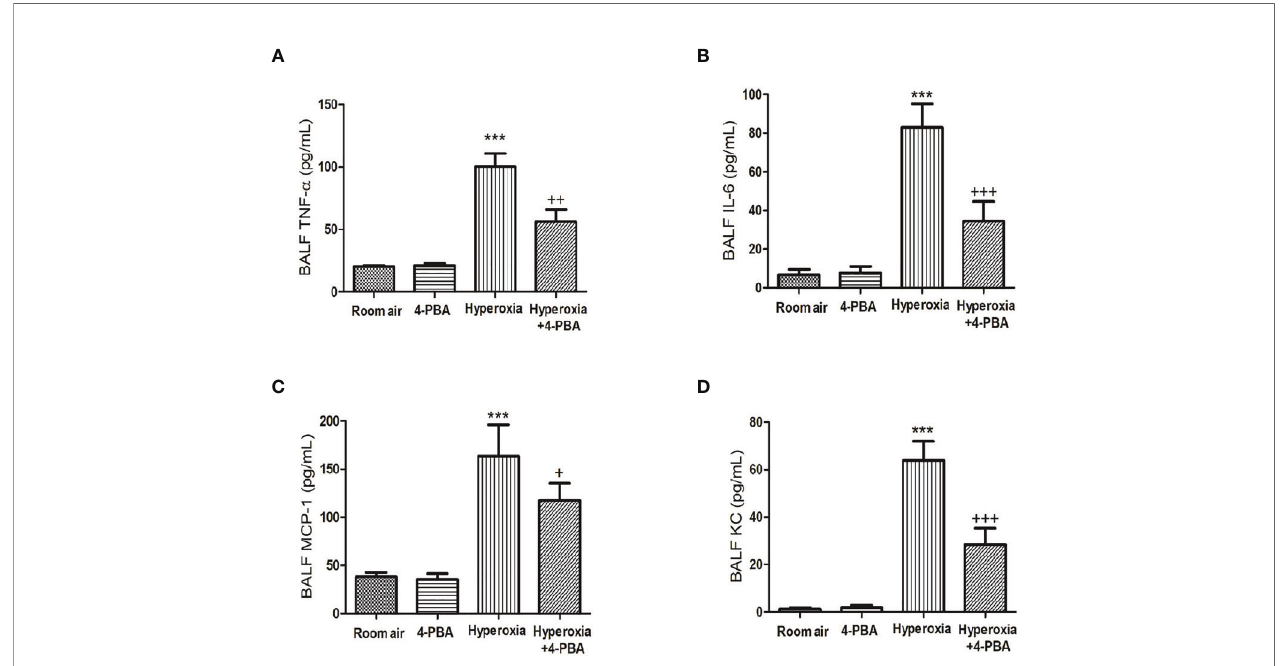
FIGURE 2 | 4-PBA alleviates hyperoxia-induced in fl ammatory mediator production in the bronchoalveolar lavage fl uid (BALF). TNF- a (A) , IL-6 (B) , MCP-1 (C) , and KC (D) levels were analyzed by ELISA in the BALF. Data are expressed as mean ± SD (6 mice per group). ***p < 0.001, compared with the room air group;